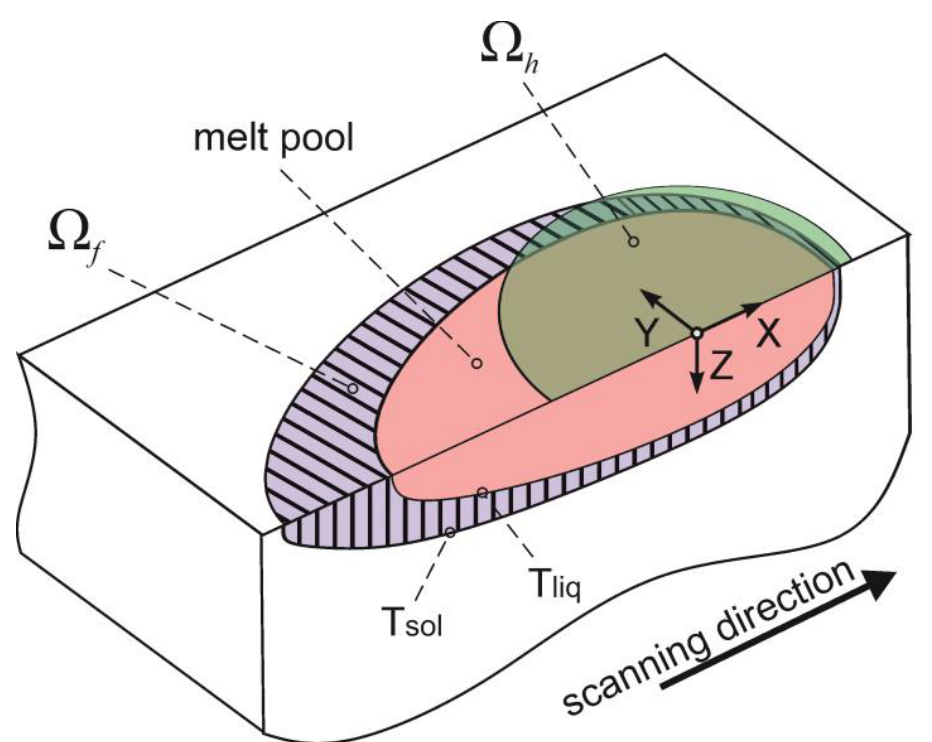
Figure 1. Scheme of the melt pool (green area — the heat source action, pink — the melt pool, purple — phase transformation region).